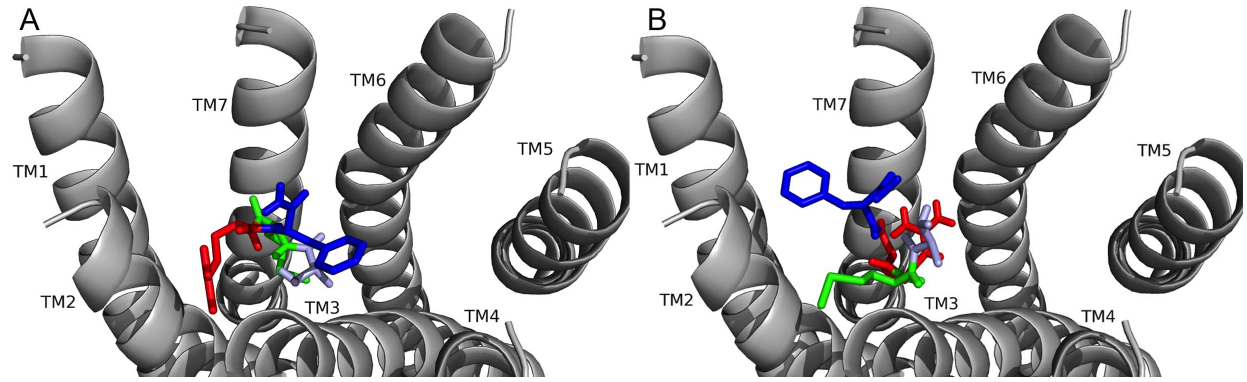
Figure 5. AMRF-NH 2 docked to FMRFa-R yielded two best poses. Two best poses (A and B) were generated in docking AMRF-NH 2 to FMRFa- R. Contacts made between the amino acids in AMRF-NH 2 are shown as A (sky blue), M (green), R (red), and F4 (blue) and the receptor, FMRFa-R, whose transmembrane regions are labeled TM # where # is 1–7. The C-terminal F was amidated, -NH 2 .